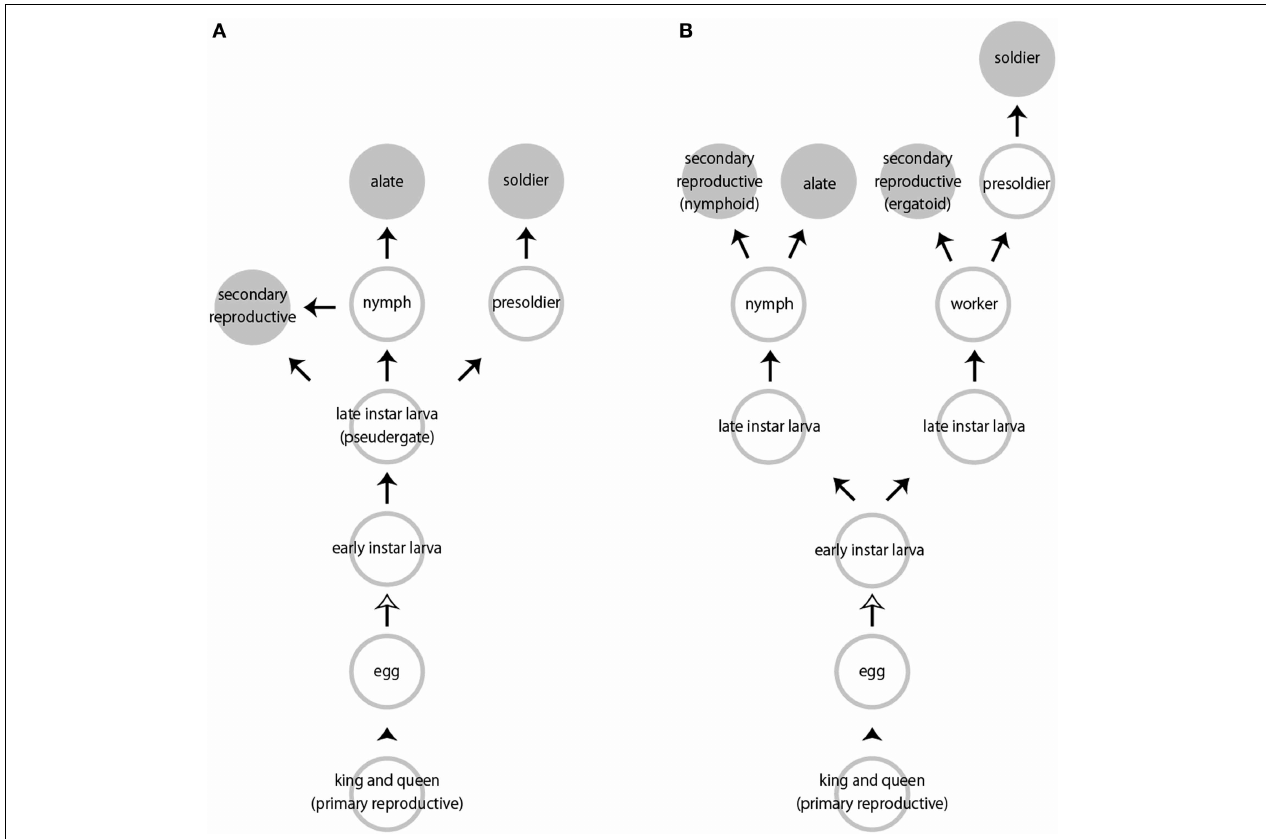
FIGURE 1 | Representative caste developmental patterns in termites. (A) Linear pathway. (B) Bifurcated pathway. Arrowheads indicate mating and oviposition. White and black arrows indicate hatching and molts, respectively. Not all pseudergates or workers molt into subsequent developmental stages.